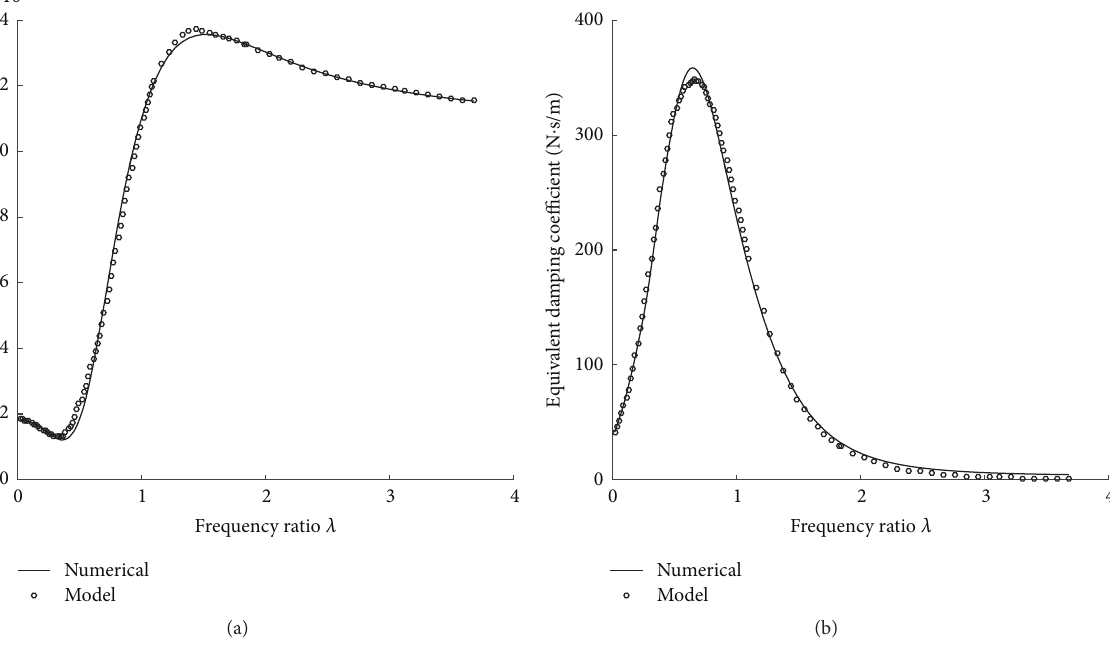
Figure 3: (a) Equivalent stiffness. (b) Equivalent damping coefficient.